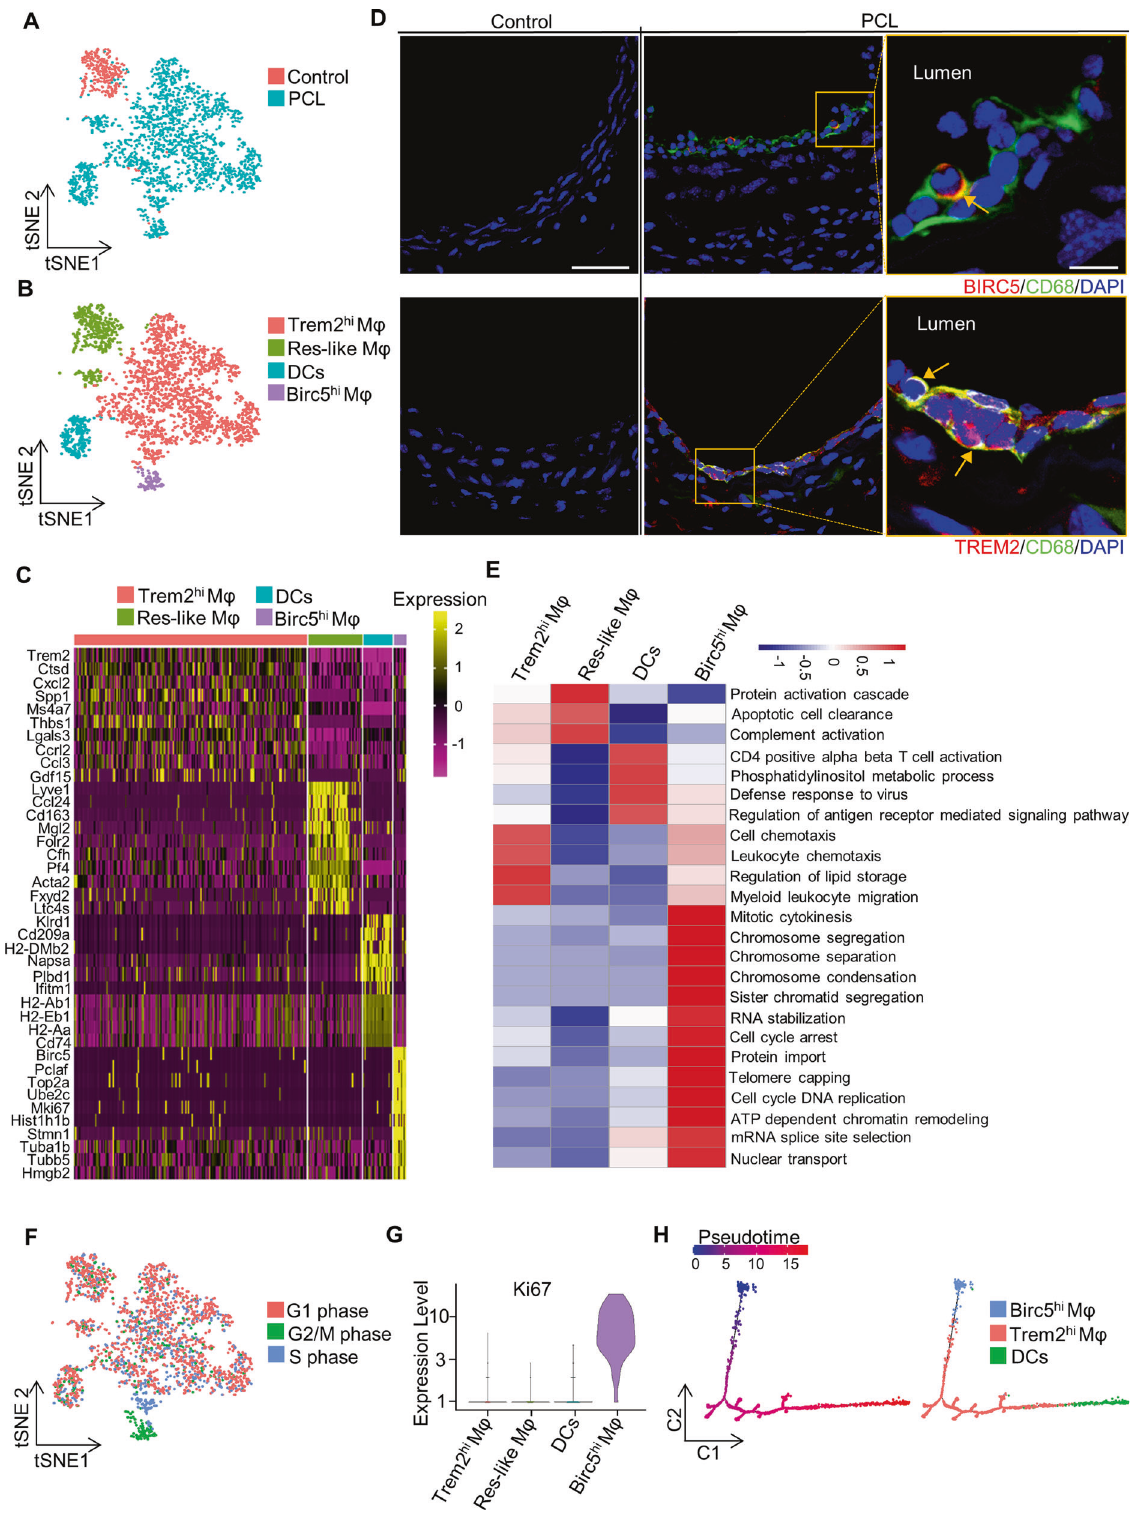
region where the d- fl ow occurs, which may participate in atherosclerosis. Together, using the d- fl ow model combined with single-cell sequencing, we identi fi ed the novel subpopulations of ECs that respond to d- fl ow in wild-type or atherosclerotic